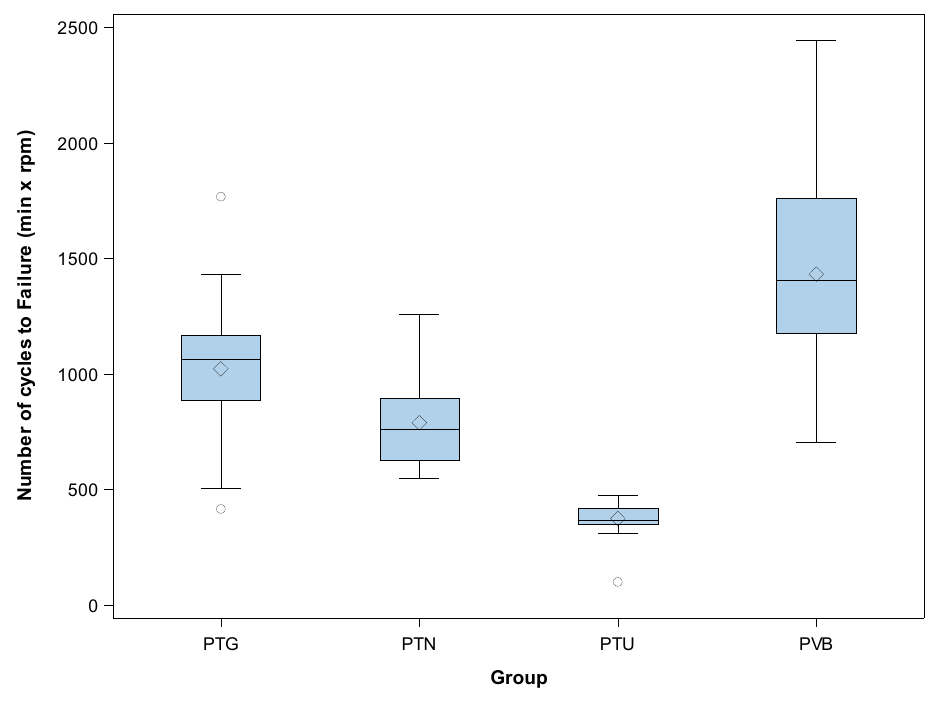
Figure 5. Box plot of the number of cycles to failure. The horizontal line in each box represents the respective median value of the study groups. ○ : Mean value of the box plots.